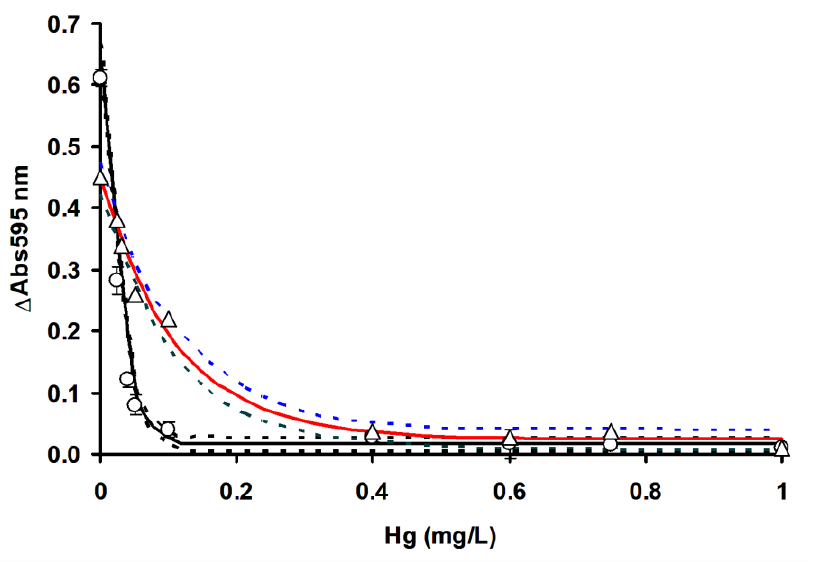
Figure 9. Ficin dye-binding assay of mercury using RSM ( ) and OFAT ( ). Dashed lines represent the 95% confidence band. Error bars represent mean ± standard deviation ( n = 3).